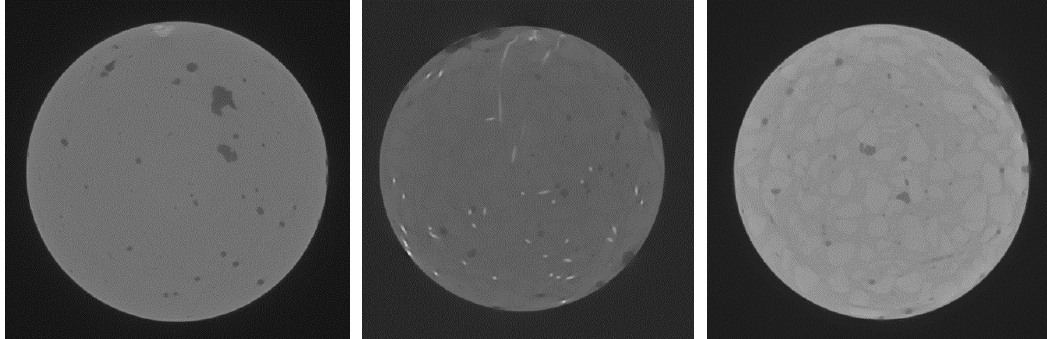
Figure 2. Slices belonging to different mixtures. From left to right, HPC, SFHPC, and PPFHPC.